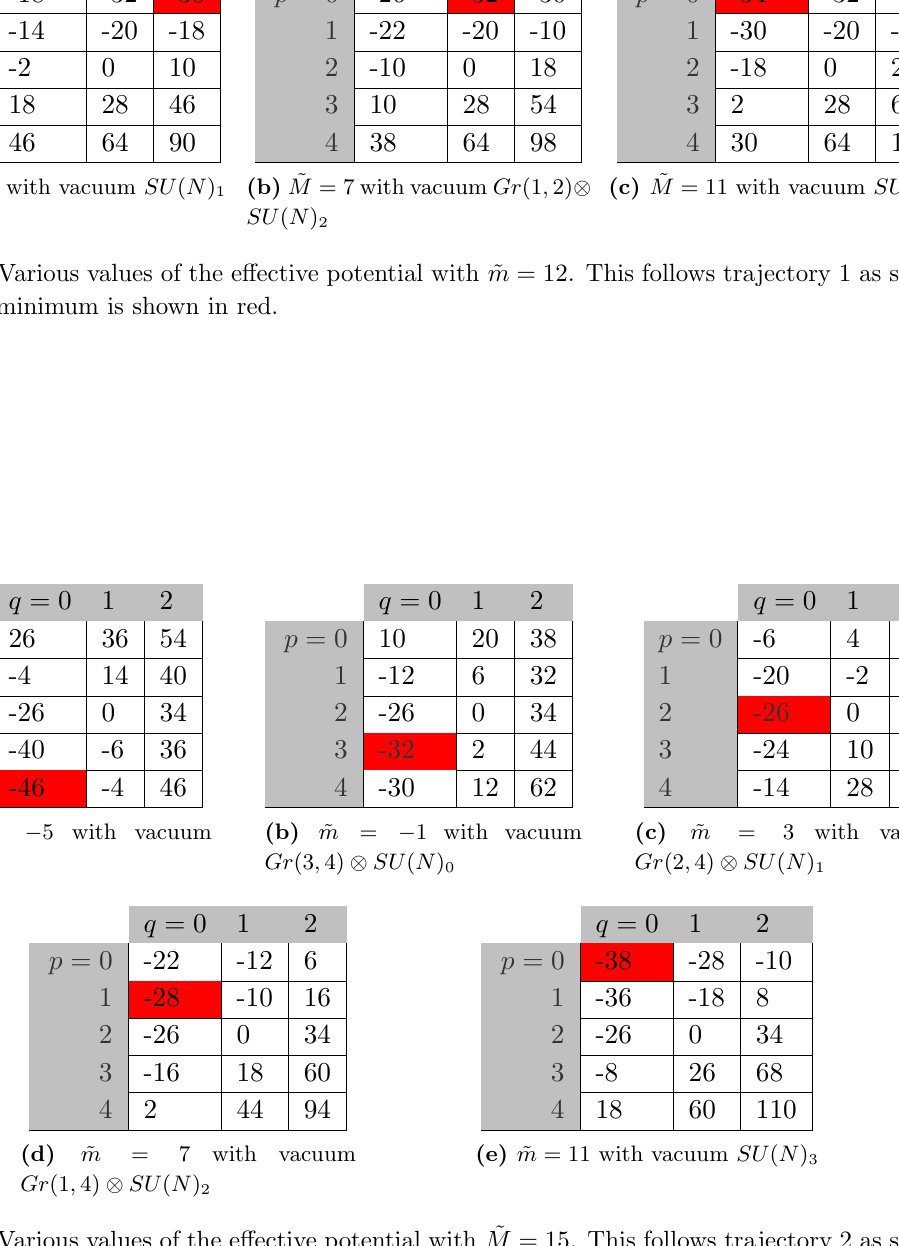
Table 2. Various values of the e(cid:11)ective potential with ~ M = 15. This follows trajectory 2 as shown in 6. The minimum is shown in